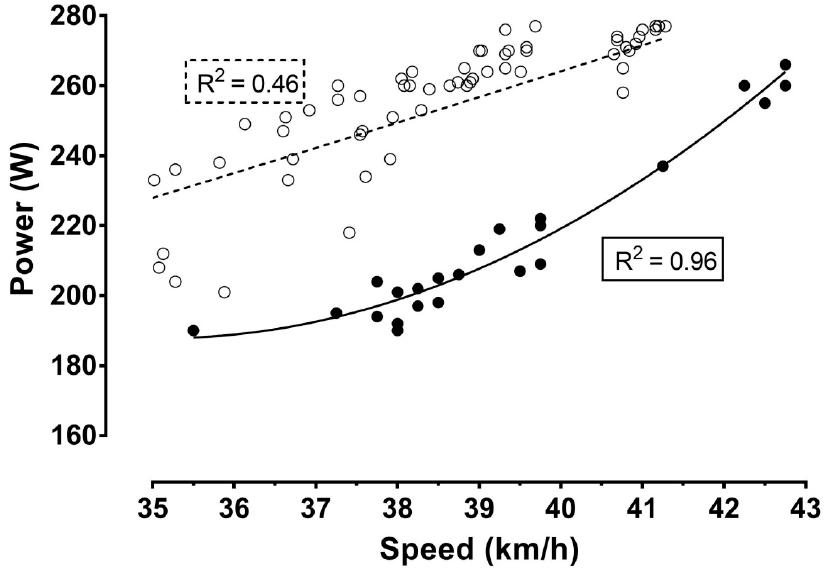
Figure 4. Relationship between power output and cycling speed. Latin numbers (I, II, III, IV) denote the phases of the race, which are separated by vertical dashed lines. The present record attempt (track cycling) is presented by (cid:8) , whereas the previous attempt (road cycling) is represented by . R 2 estimates the goodness of fit.